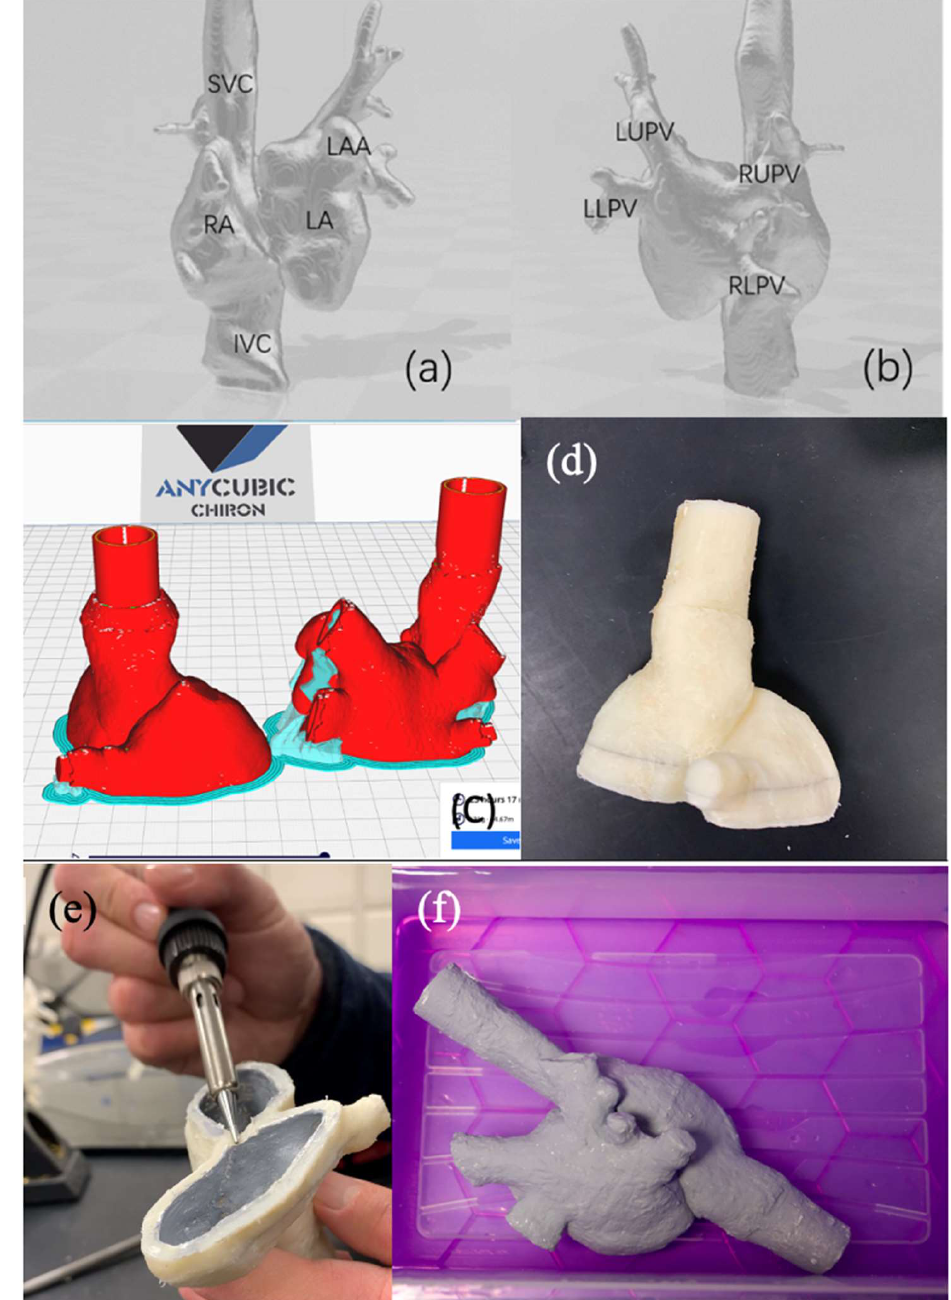
Figure 7. Bi-atrial model rendering from ( a ) anterior view and ( b ) posterior view. ( c ) Bi-atrial model cut into two sections for ease of printing and coating. ( d ) Lower section printed in Layfomm-40. ( e ) Lower section coated internally with paint layers and ready for plastic welding. ( f ) Fully welded and external-paint-coated bi-atrial model soaked in saline solution. SVC—superior vena cava, IVC—inferior vena cava, RA—right atrium, LA—left atrium, LAA—left atrial appendage, LUPV— left upper pulmonary vein, LLPV—left lower pulmonary vein, RUPV—right upper pulmonary vein, and RLPV—right lower pulmonary vein.